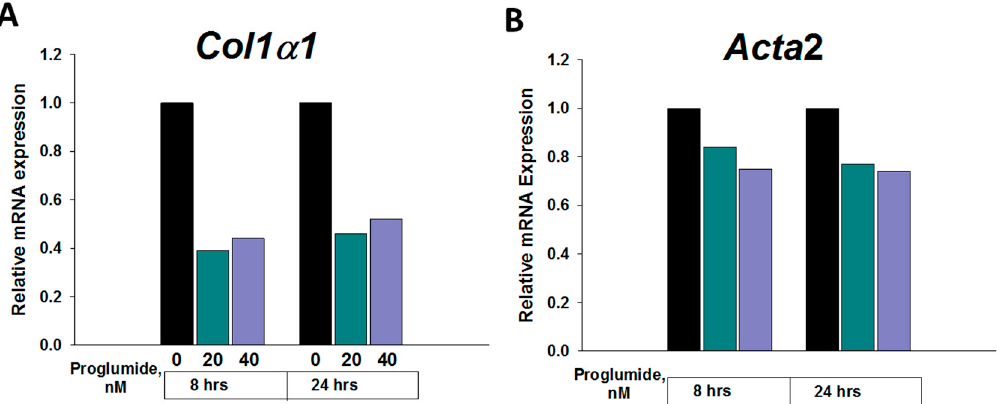
Figure 5. Relative mRNA expression of the fibrosis genes in Dt81Hepa1-6 HCC. Cells were untreated (0) or treated with proglumide (20 or 40 nM) for either 8 or 24 h. ( A ) Relative mRNA expression by qRT-PCR of Col1 α 1 and ( B ) Relative mRNA expression by qRT-PCR of Acta2 .